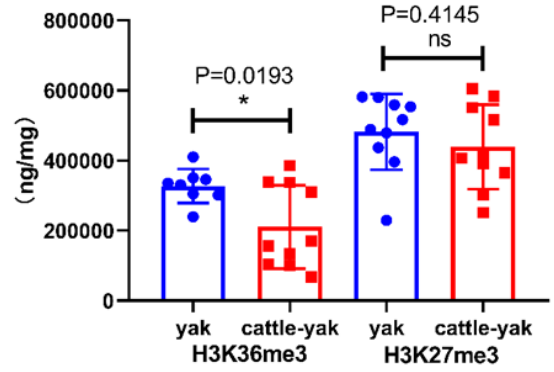
Figure 3. The levels of H3K36me3 and H3K27me3 in the testes of yaks and cattle-yaks. * p < 0.05. Test for normal distribution of H3K36me3 (P yak = 0.5018, P cattle-yak = 0.0797); Test for normal distribution of H3K27me3 (P yak = 0.1168, P cattle-yak =